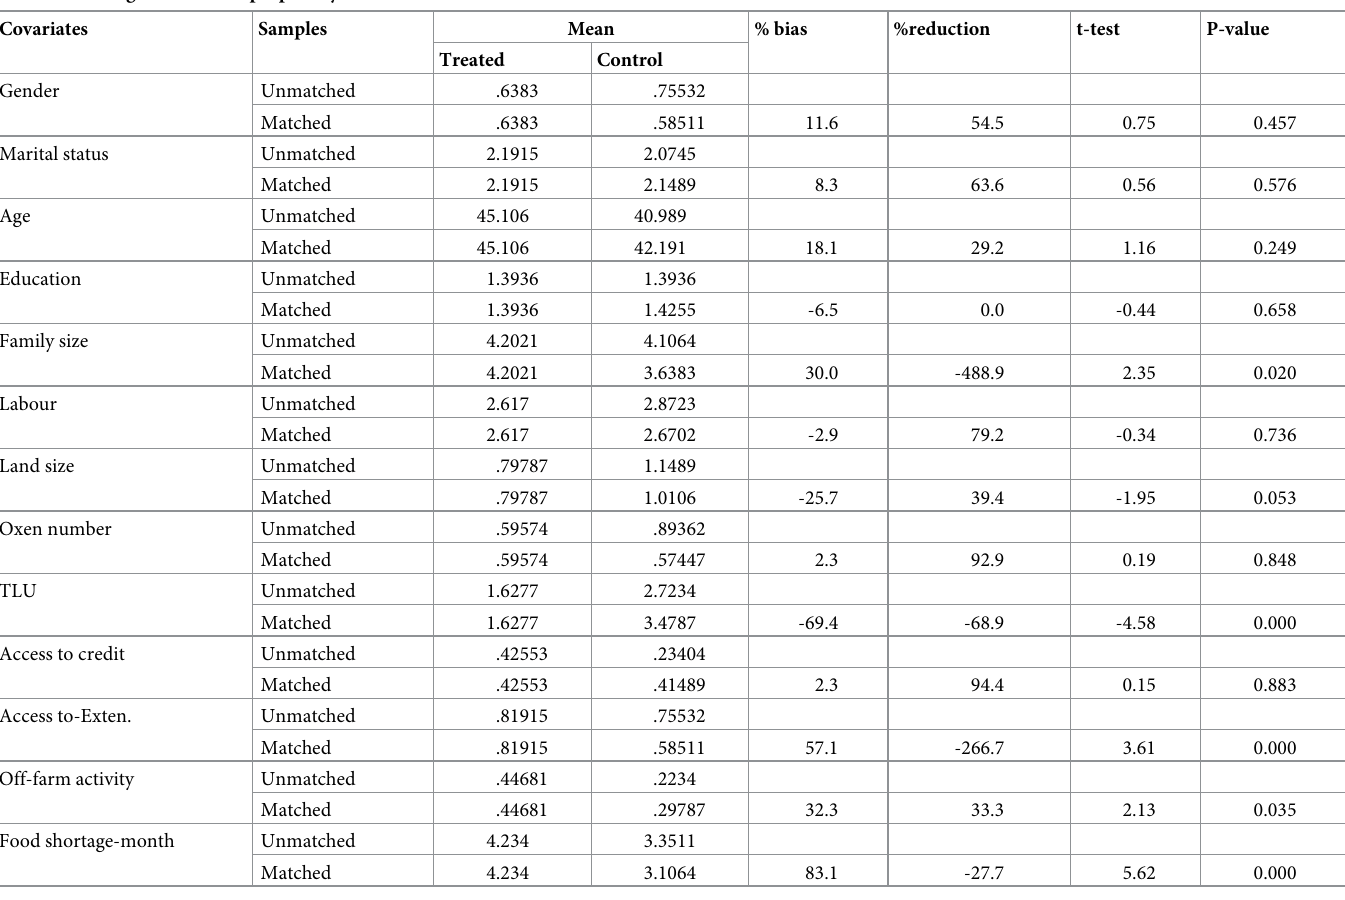
Table 8. Testing of balance of propensity score and covariates. Covariates